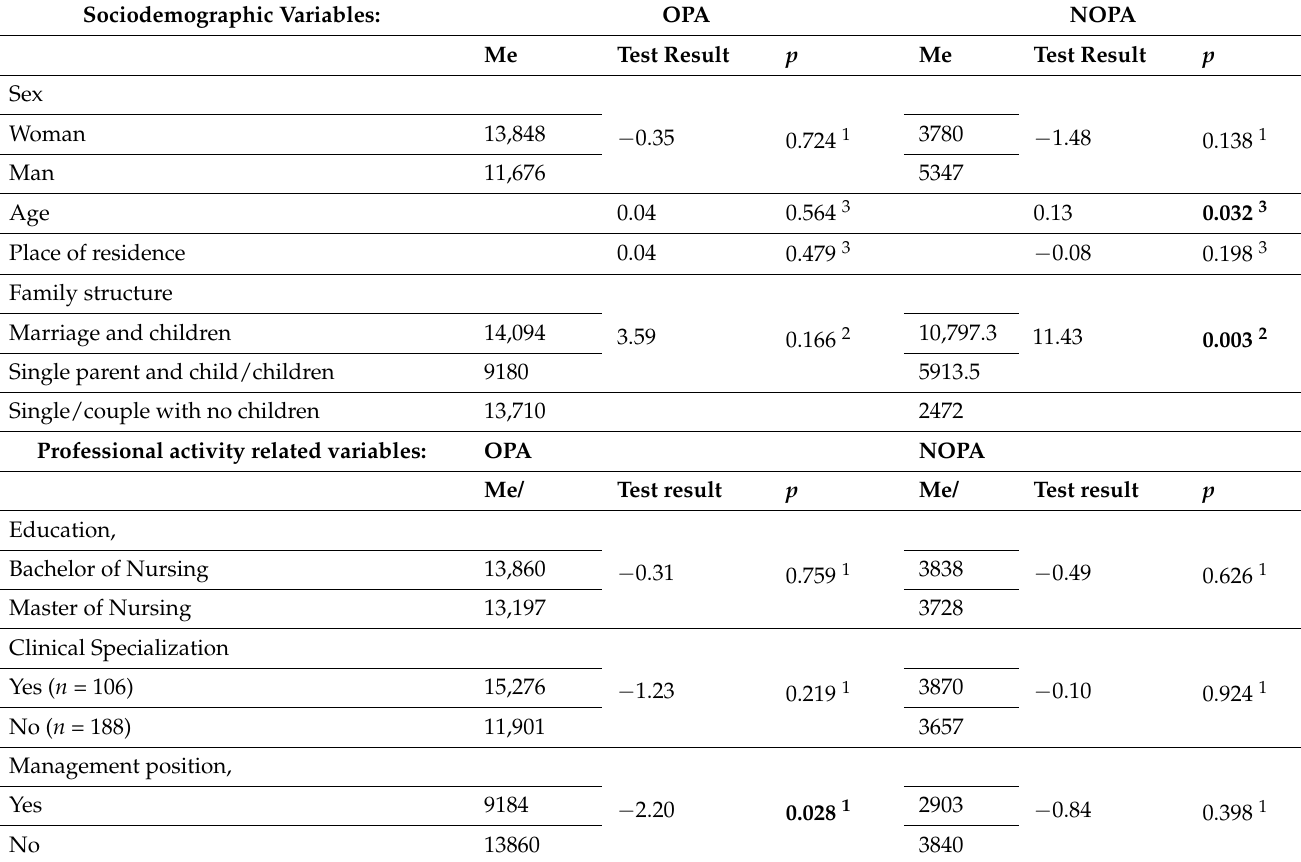
Table A3. The detailed results of the differences in OPA and NOPA depending on sociodemographic and professional